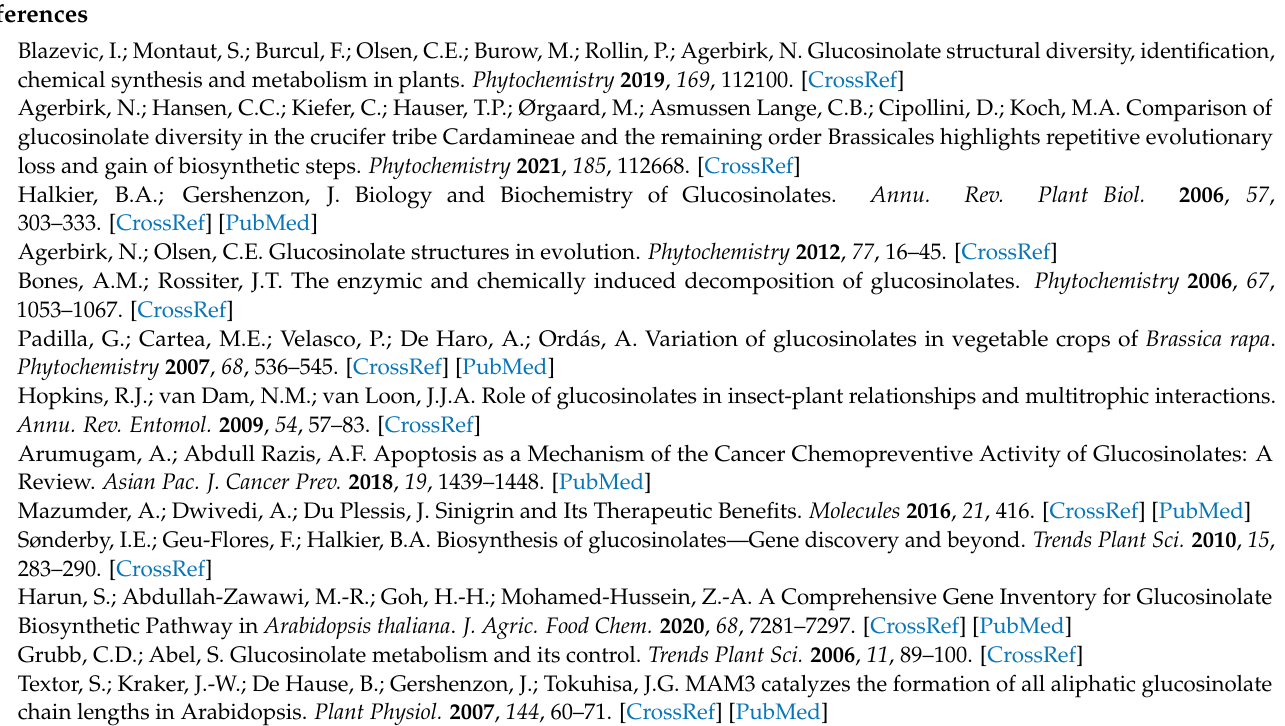
different organs of Brassica nigra. Figure S2: Correlation analysis of samples. Table S1: GSL genes reported in Brassica rapa and Brassica oleracea. Table S2: List of primers used for qRT-PCR. Table S3: The DNA, CDS and amino acid sequences of glucosinolate biosynthetic related genes (BniGSLs) in Brassica nigra. Table S4: Expression data of BniGSL genes in